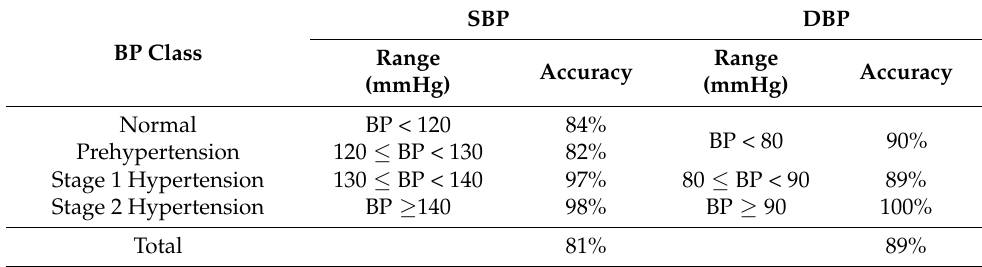
Table 10. Hypertension classification accuracies for SBP and